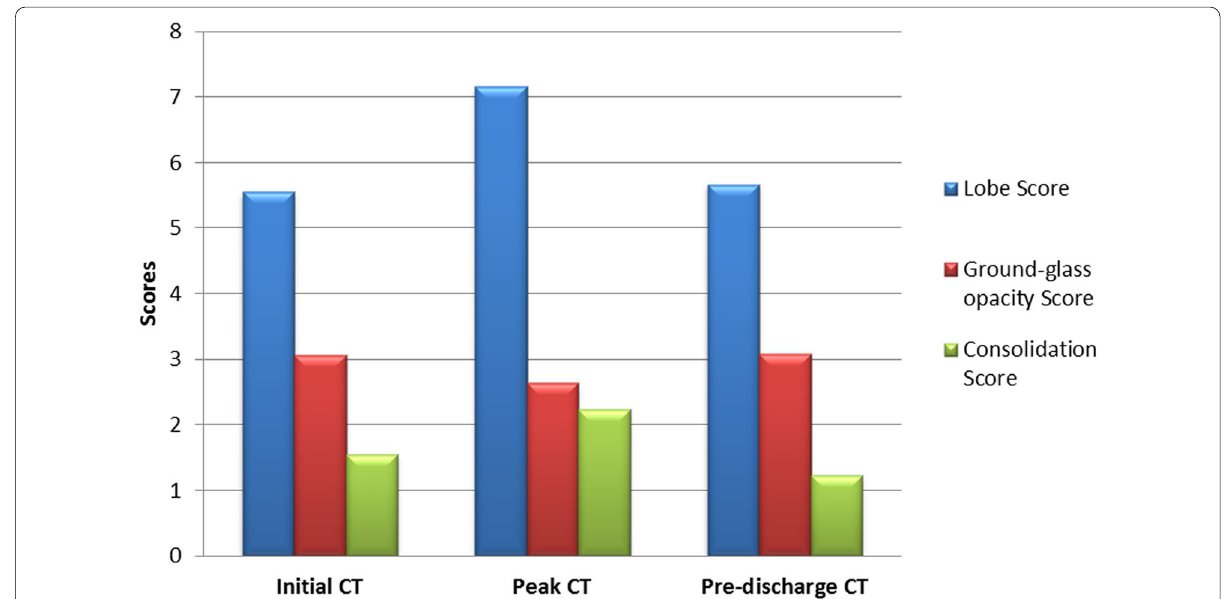
Fig. 6 The lobe score, ground‑glass opacity score, and consolidation score on initial CT, peak CT, and pre‑discharge CT